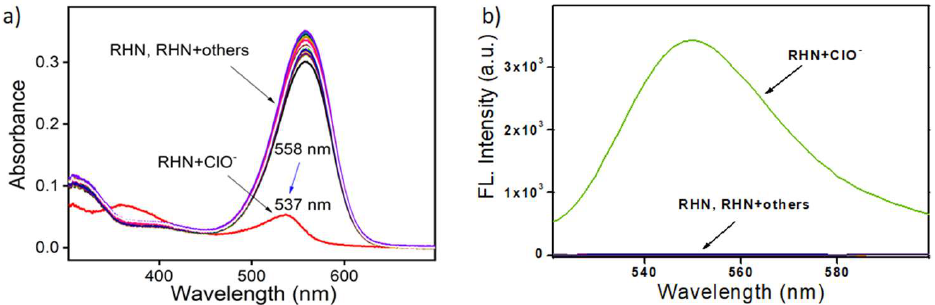
Figure 1. ( a ) Absorption spectra response of RHN (10 μM; 10 mM, pH = 7.4, PBS) upon addition of different species (10 equiv.); ( b ) Emission spectra response of RHN (10 μM; 10 mM, pH = 7.4, PBS) upon addition of different species (10 equiv.). Different species: (1) 1 O 2 ; (2) Cys; (3) GSH; (4) H 2 O 2 ; (5) ClO − ; (6) Hcy; (7) HSO 3 − ; (8) HSO 4 − ; (9) TBHP; (10) NO; (11) NO 2 − ; (12) NO 3 − ; (13) O 2 − ; (14) •OH; (15) ONOO − ; (16) S 2− ; (17) S 2 O 32− ; (18) S 2 O 42− ; (19) S 2 O 82− ; (20) SO 32− ; (21) SO 42− ; (22) blank. The conditions: PBS buffer (10 mM, pH = 7.4); λ ex = 500 nm; slits: 10/5 nm.